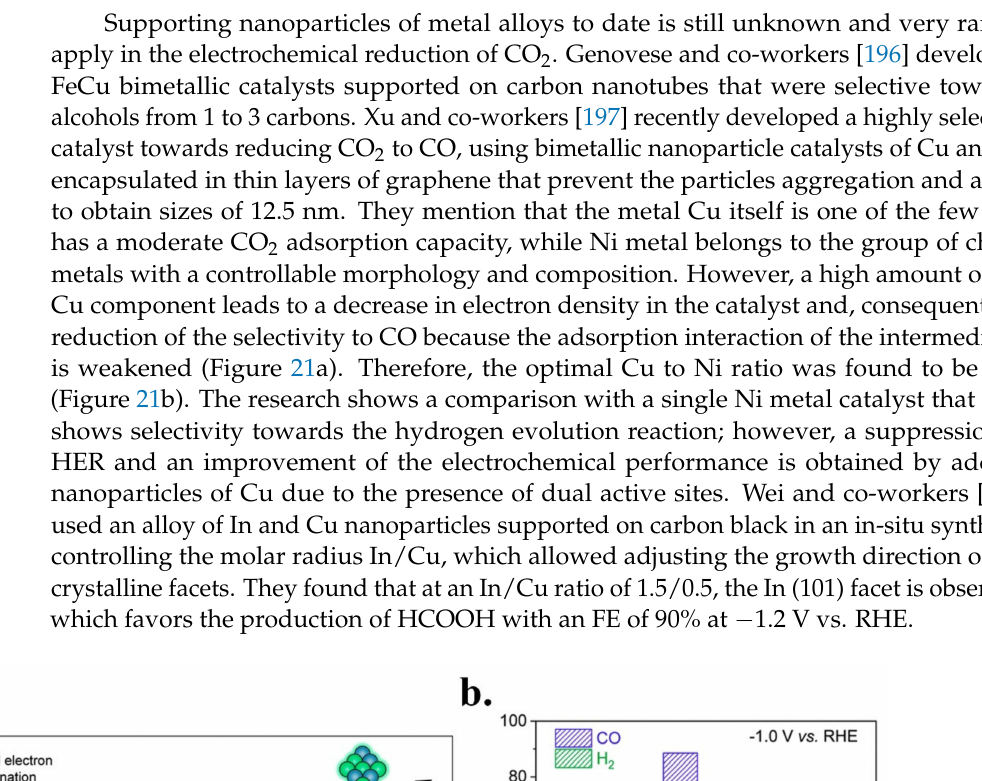
Figure 20. ( a ) CO* intermediate stabilization and dimerization process on nitrogen and copper doped graphene oxide catalysts and ( b ) comparison of electrochemical enhancement by doping GO with nitrogen and Cu simultaneously. Adapted from [191].